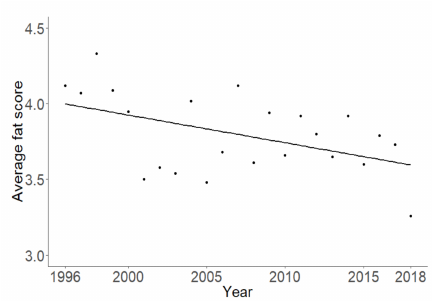
Figure 3. Average fat score of the Pied Flycatchers during stopover over the